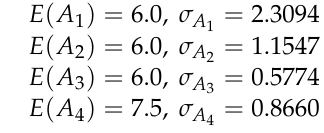
Table 3. The comparison of defuzzifying approaches in Example